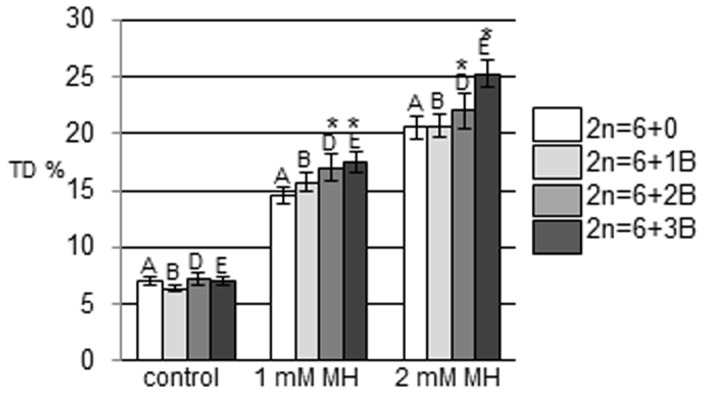
DNA damage (% tail DNA) in control and MH treated cells with a different number of B chromosomes.The bars indicate standard errors (SE).) The capital letters A, B, D, E indicate that the % tail DNA values after treatments are significantly different (P<0.05) from the % tail DNA of the control groups for the cells with the same number of B chromosomes. An * indicates that the % tail DNA values in 0B cells are significantly different (P<0.05) from the % tail DNA in cells with B chromosomes within the same treatment.